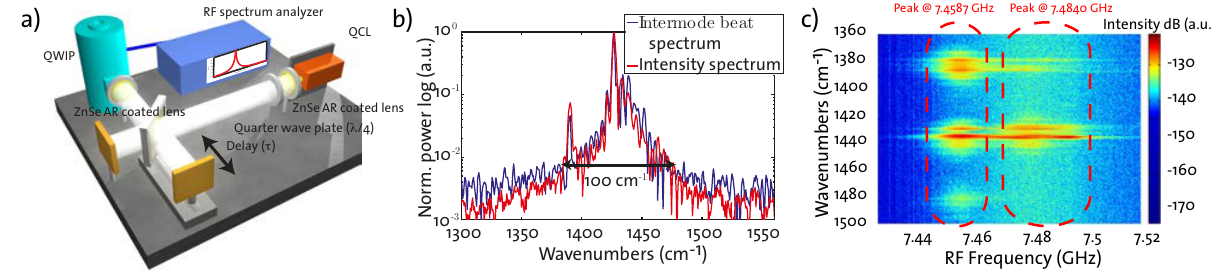
Figure 14: Intermode beat spectroscopy. a Schematic representation of an intermode beat spectroscopy experiment. The output of a FTIR is sent to a high-bandwidth (20GHz 3dB cut-off) QWIP detector, in order to measure the intermode beatnote spectrum with a spectrum analyzer. (AR: anti-reflection). b Intermode beat spectrum together with the normal intensity spectrum of the laser, showing that the en- tire spectrum is contributing to the generation of the beatnote at the comb repetition frequency. c Intermode beat spectrum acquire over a large span ( 100 MHz), for driving conditions where the QCL is not operating as a comb, and yielding important informations about the comb destabilization mechanisms. Two broad beatnotes are observed on the RF spectrum. The peak at ν = 7.4840GHz involves mostly modes which are near the center of the optical spectrum ( ω ≃ 1430 cm −1 ) while the peak at ν = 7.4587GHz corresponds to modes locked for a wider bandwidth (from ω = 1360 cm −1 to ω = 1500 cm −1 ). Results published in